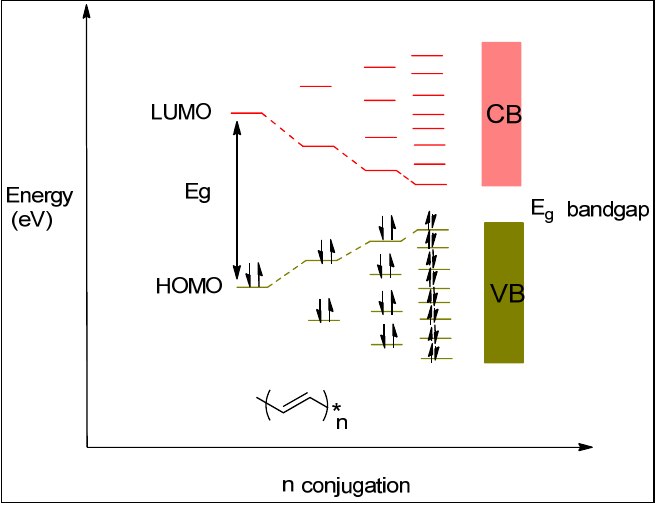
Figure 3. Energetic diagram profile showing the effect of increasing the number of conjugated π -bonds on the magnitude of the EBG of the conjugated polymer.